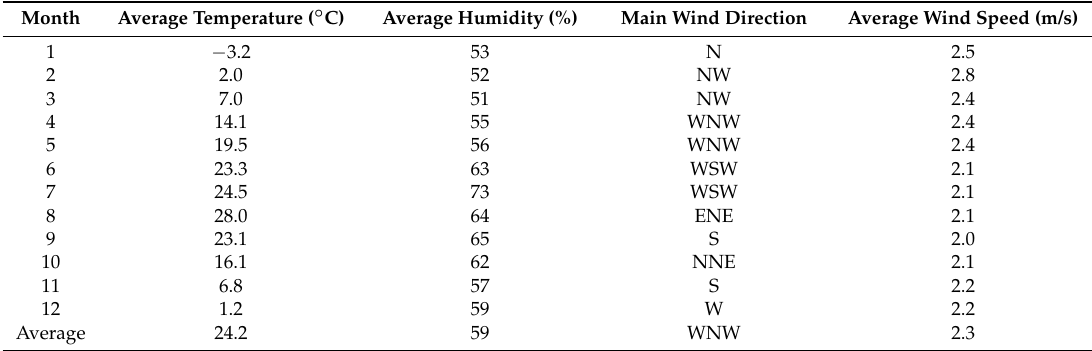
Table 4. Operating meteorological conditions for month (Ulsan industrial complex).